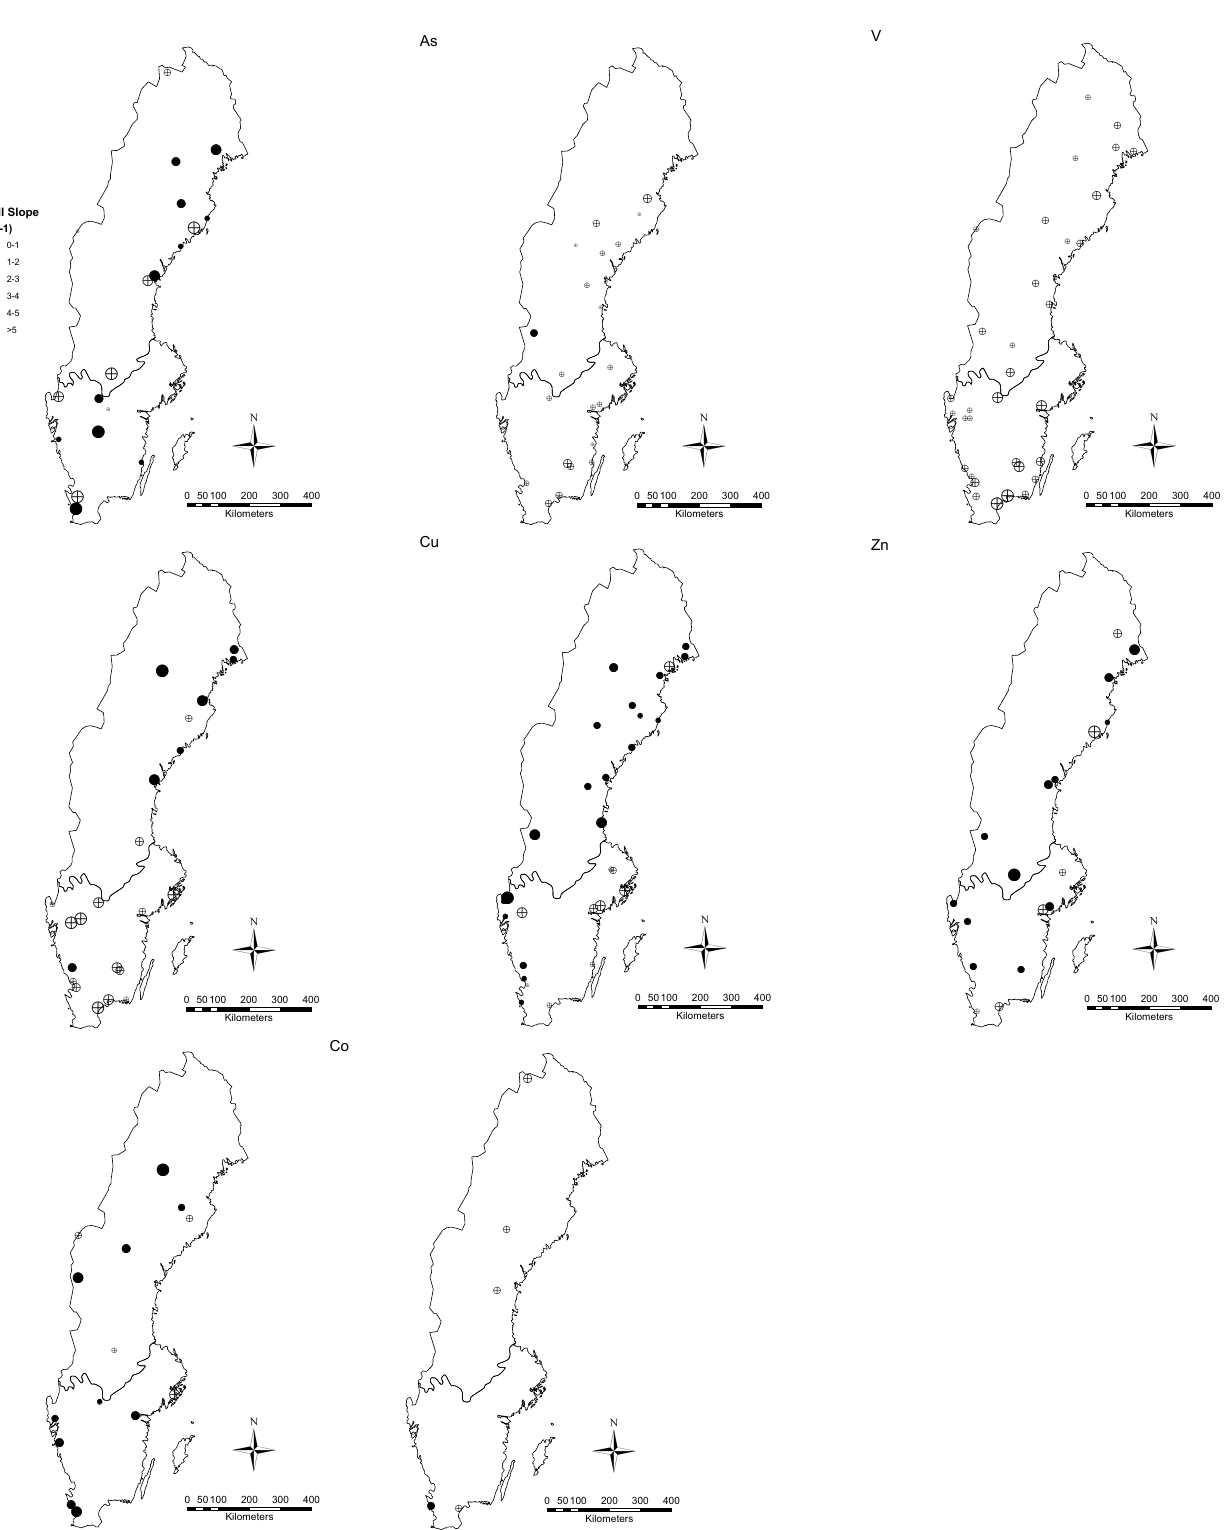
Fig. 3. Metal trends indicated by shaded (negative) or crossed, open (positive) circles. The size of the circle represents the magnitude of the trend slope in %yr − 1